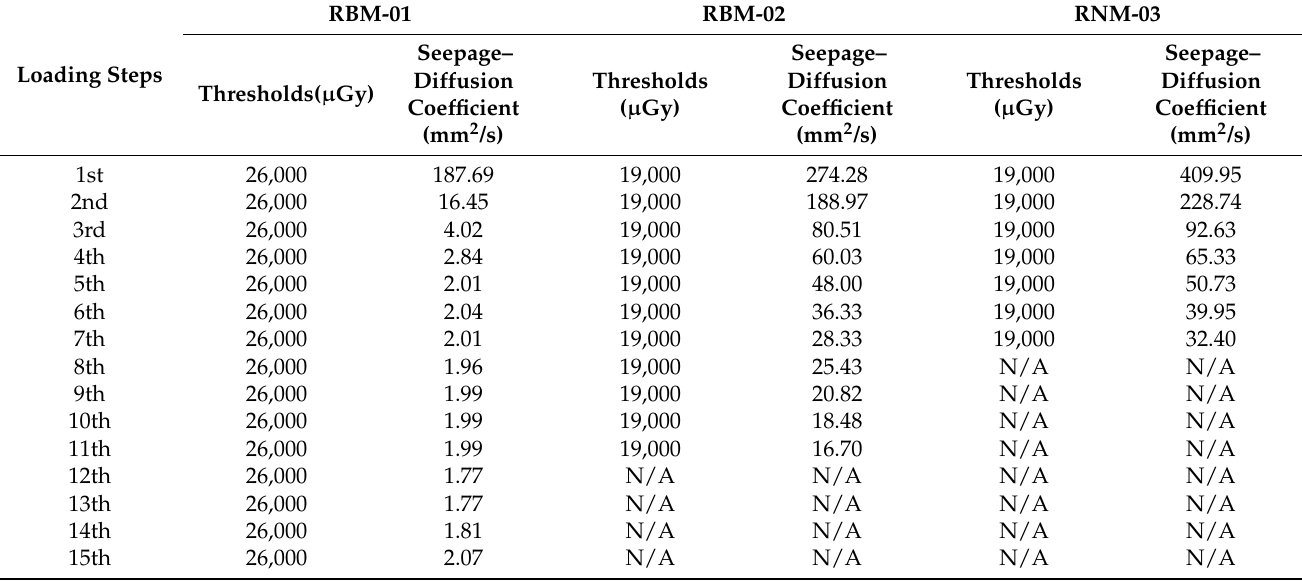
Table 4. Calculation Results of the Seepage–Diffusion Coefficient in Mudstone Specimen